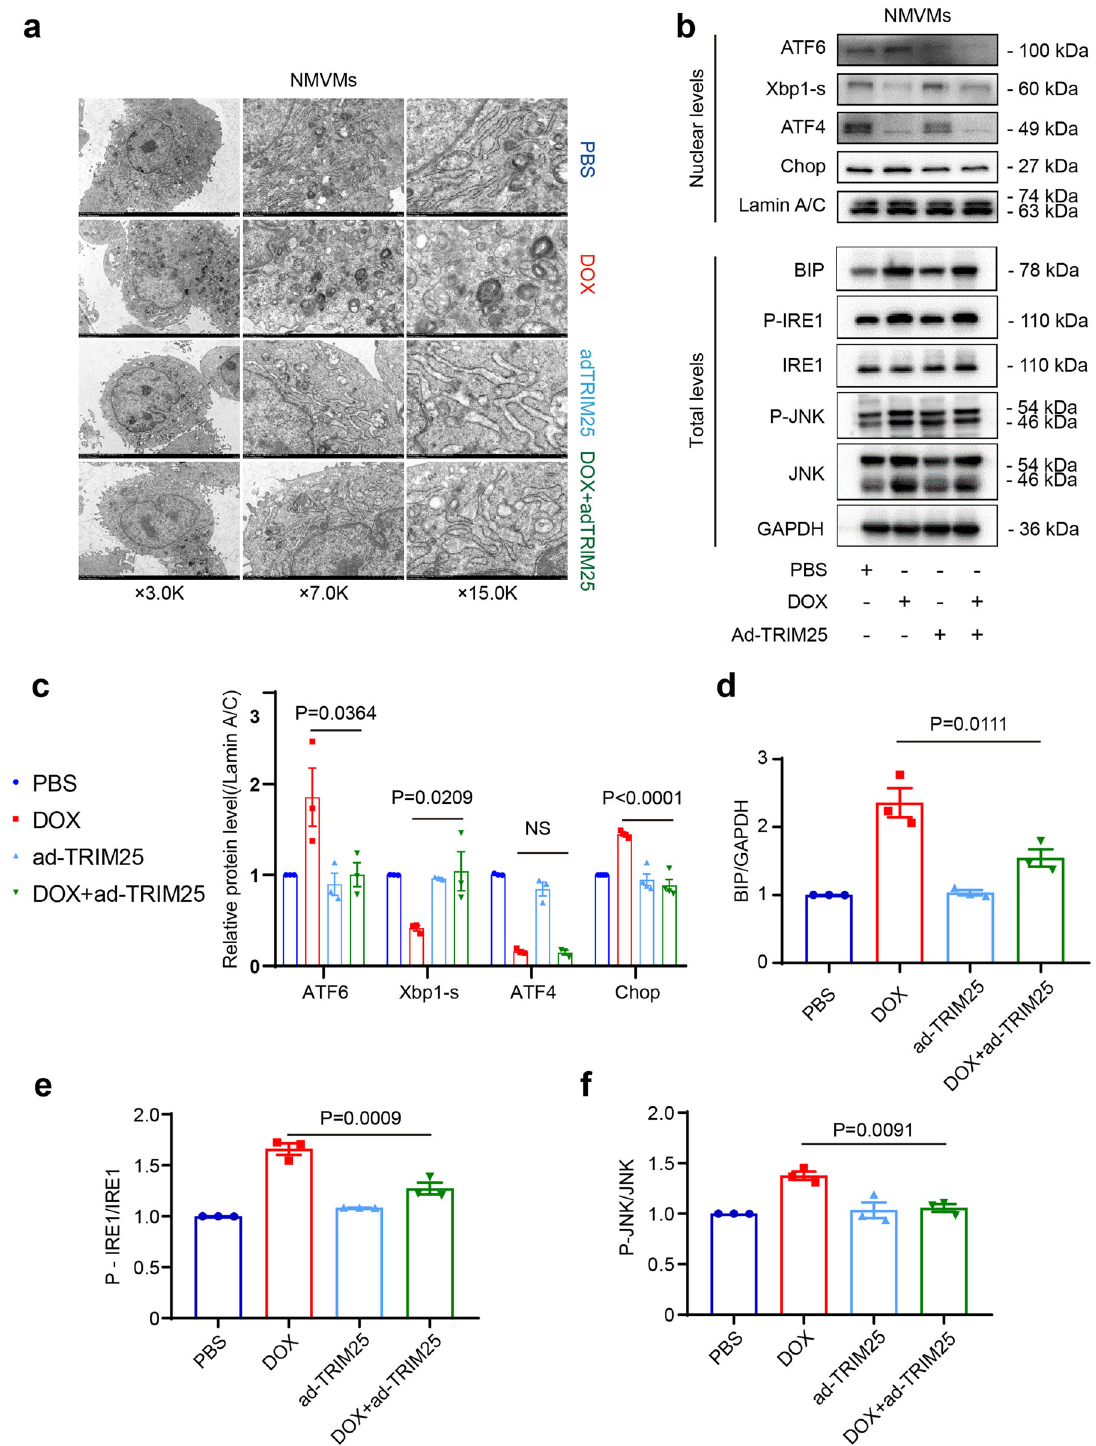
Fig. 5 TRIM25 overpression by adenovirus attenuates DOX-induced apoptosis and endoplasmic reticulum stress in cardiomyocytes. a DOX-induced NMVMs were transfected with Ad-TRIM25 and assessed by transmission electron microscopy. b Representative western blotting (above) and the corresponding quanti fi ed graph ( c – f ) (below) of Atf6, Atf4, XBP1-s, and Chop in the nuclear fraction and BIP, P-IRE1, IRE1, P-JNK, and JNK in the total protein of NMVMs. Data represent the means ± SEM ( n = 3 – 5). P values were analyzed by one-way ANOVA test with Bonferroni post hoc test ( c , d , e , f ). Ad-TRIM25, adenovirus-TRIM25; NS not signi fi cant, NMVM neonatal mouse ventricular myocytes.